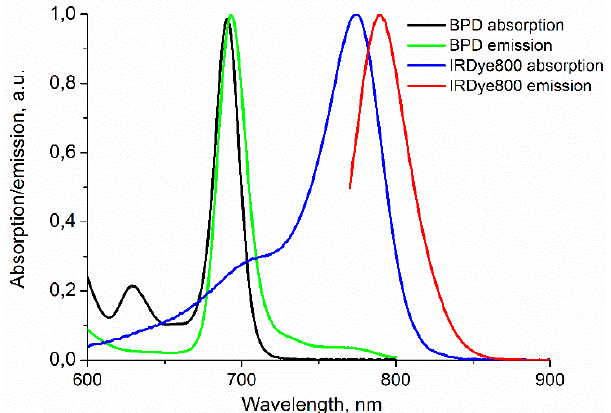
Figure 2. Absorption and emission spectra of benzoporphyrin derivative (BPD) and IRDye800.